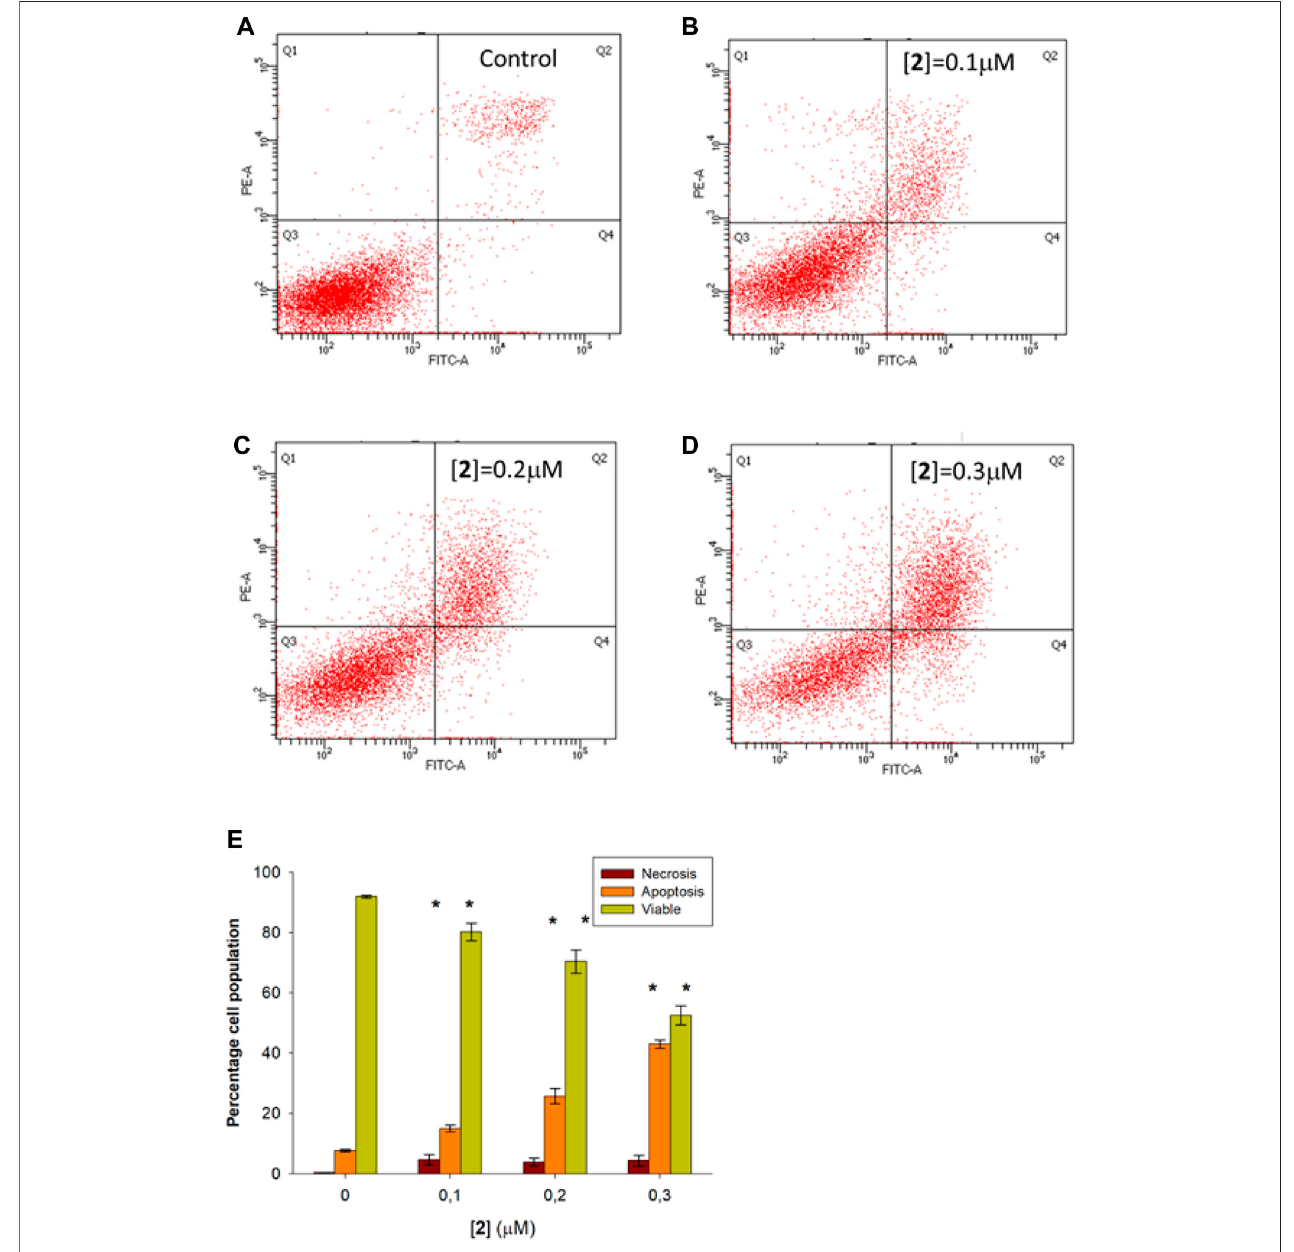
FIGURE2| Flow cytometric analysisofapoptosis inA2780 cells treatedwith 2 .A2780 cells wereincubated for48 hwith compound 2 at indicated concentrations and analyzed by fl ow cytometer after staining with FITC-conjugated Annexin V and PI. The dot plots show a representative experiment for untreated (control, (A) and treated cells at 0.1, 0.2, and 0.3 μ M concentration ( B – D , respectively). Bar chart (E) represents the percentage of viable (Q3), early plus late apoptosis (Q4+Q2), and necrotic (Q1) cells as a mean ± SD of three independent experiments in duplicate with * p , 0.05 (sample vs .